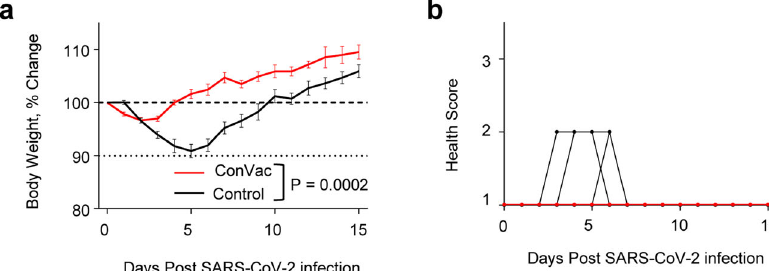
Fig. 4 Hamster body weight change and health scores upon SARS-CoV-2 infection. Hamsters were vaccinated at day zero and challenged intranasally with 10 5 PFU SARS-CoV-2 at day 31. a % change in body weight and b individual disease score. Data represent mean ± SEM. VSV vaccine is shown in red and control group in black. N = 12 for control group (six hamsters euthanized at day three post challenge) and N = 10 for ConVac group ( fi ve hamsters euthanized at day three post challenge). Body weight P value determined by Wilcoxon test.